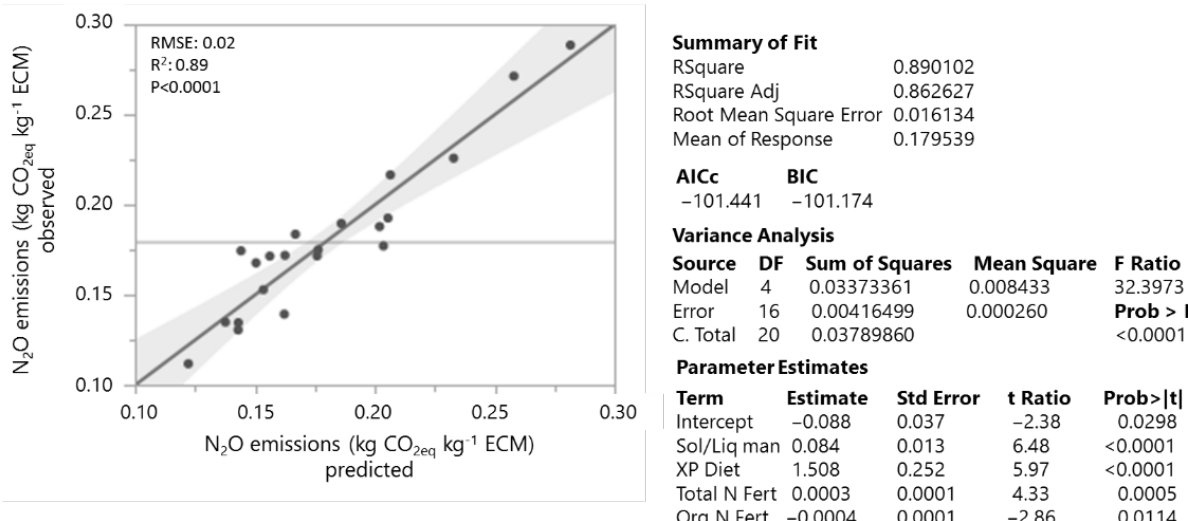
Figure 7. Effects of the dairy farm parameters (manure type, solid or liquid manure (Sol/Liq man), crude protein content (XP Diet), total nitrogen fertilisation (Total N Fert) and organic nitrogen fertilisation (Org N Fert)) on the total N 2 O emissions, expressed as kg CO 2eq kg −1 ECM.